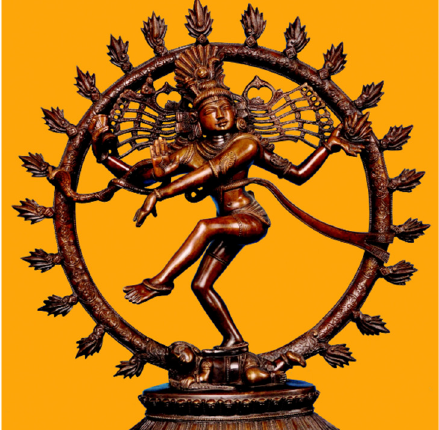
Figure 6. Classically, Ś iva is depicted as the Lord of Dance, Na ṭ ar ā ja, who experiences from a state of flux. In this classic depiction he is seen dancing on a demon (picture by Lathish, Canva ).